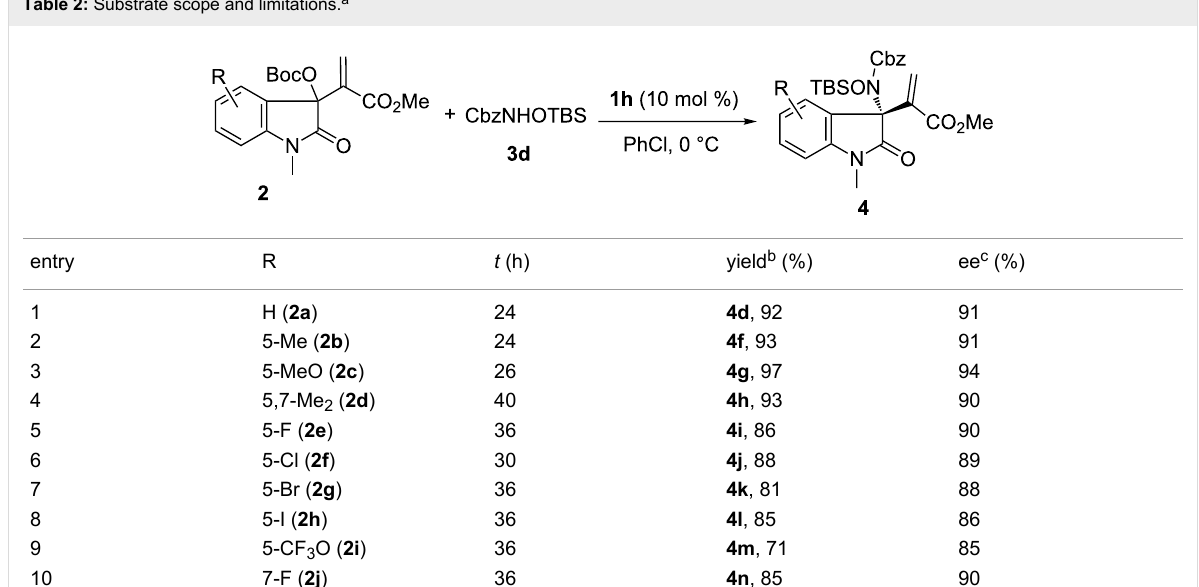
Table 2: Substrate scope and limitations.